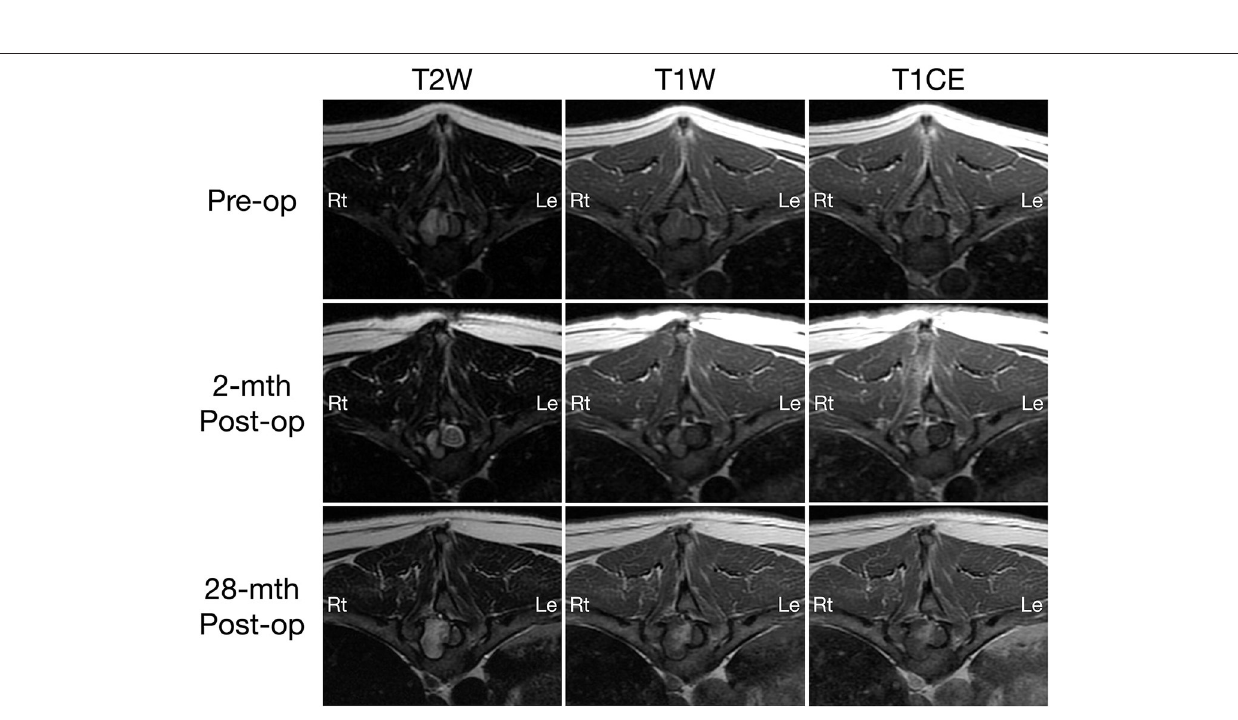
Frontiers in Veterinary Science |